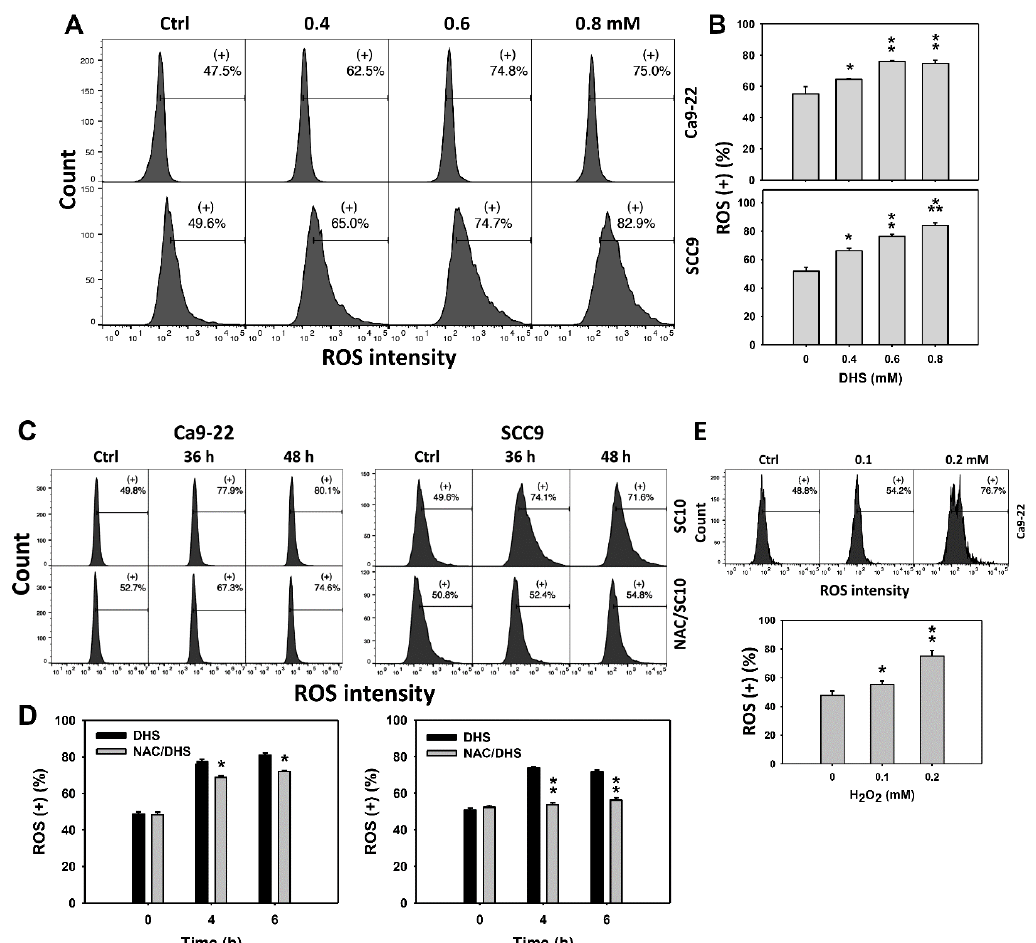
Figure 5. DHS effects on ROS contents of oral cancer cells. ( A , B ) Representative ROS patterns of DHS-treated oral cancer cells. Cells (Ca9-22 and SCC-9) were treated with vehicle (containing 0.08% DMSO), 0.4, 0.6 and 0.8 mM DHS for 48 h. (+) indicates the high ROS populations. ( C , D ) Alleviation of ROS changes in DHS-treated oral cancer cells by NAC. Cells were pretreated with NAC (4 mM, 1 h) or not, and then they were treated with 0.6 mM DHS or vehicle for 0, 36 and 48 h. ( E ) Positive control for ROS induction. Cells (Ca9-22) were treated with H 2 O 2 (0, 0.1 and 0.2 mM) for 24 h. Data = means ± SDs ( n = 3 independent experiments). *, ** and *** indicate significant differences between ( A , B ) DHS and control and ( C , D ) DHS and NAC/DHS ( p < 0.05, 0.01 and 0.001,